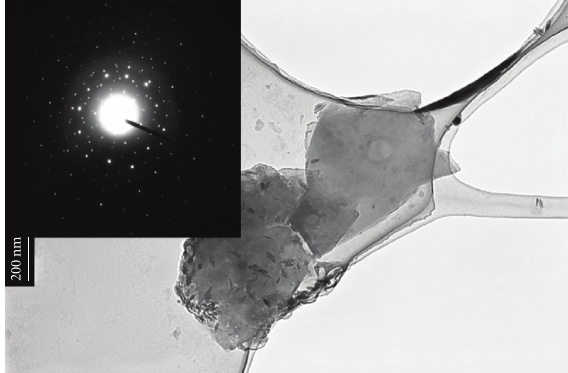
Figure 3: SEM micrograph of 40-hour refluxed nanocrystalline Cu 0 . 95 Fe 0 . 05 O showing the mixture of rod-like and platelet-like particles.